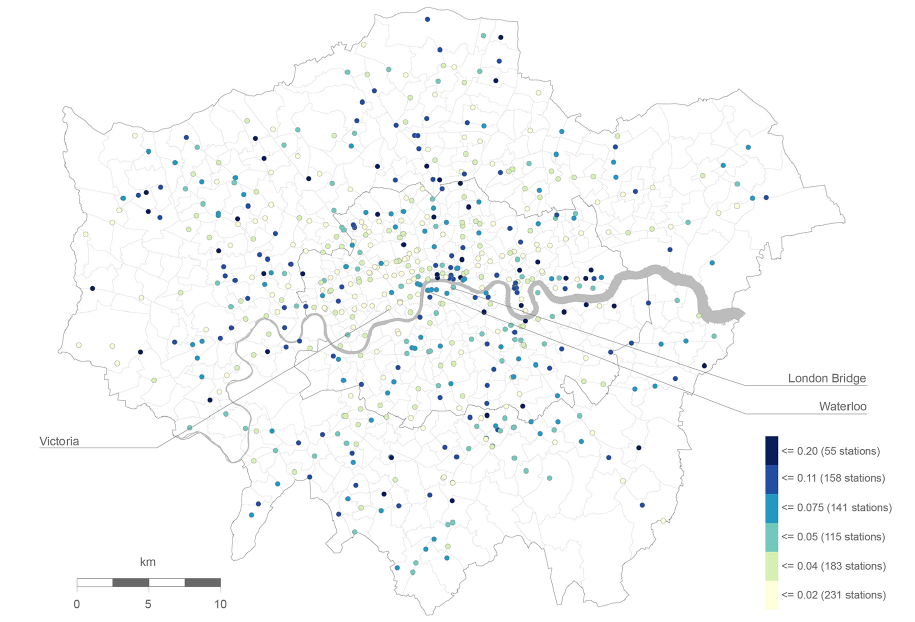
Figure 5: Spatial distribution of the consistency calculated for an average week day.